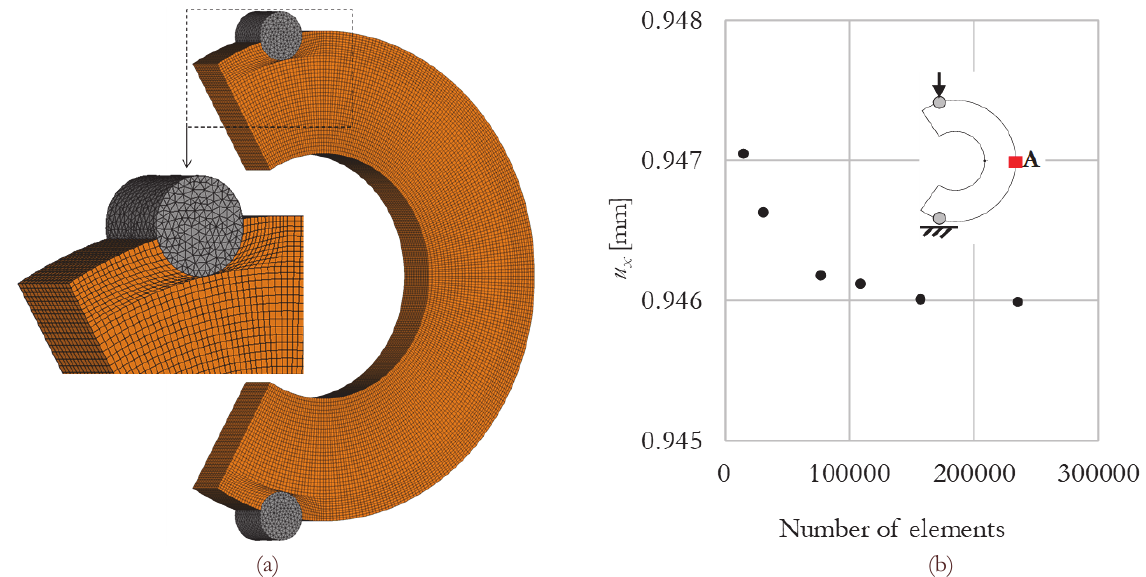
Figure 7: (a) The three dimensional numerical model properly meshed with 155000 elements; (b) The dependence of the horizontal displacement u x ≡ u of point A on the number of elements used for meshing the numerical